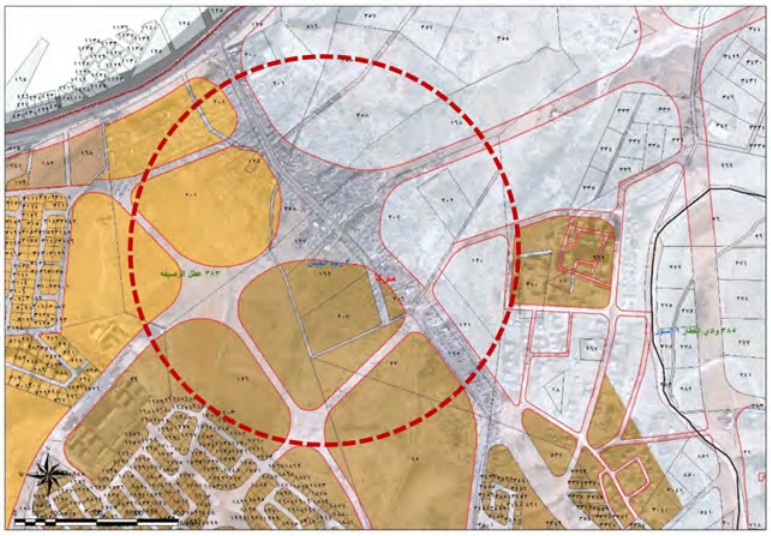
Figure 26. Scrap yard site land use over aerial view map. Source: GAM- GIS for the author